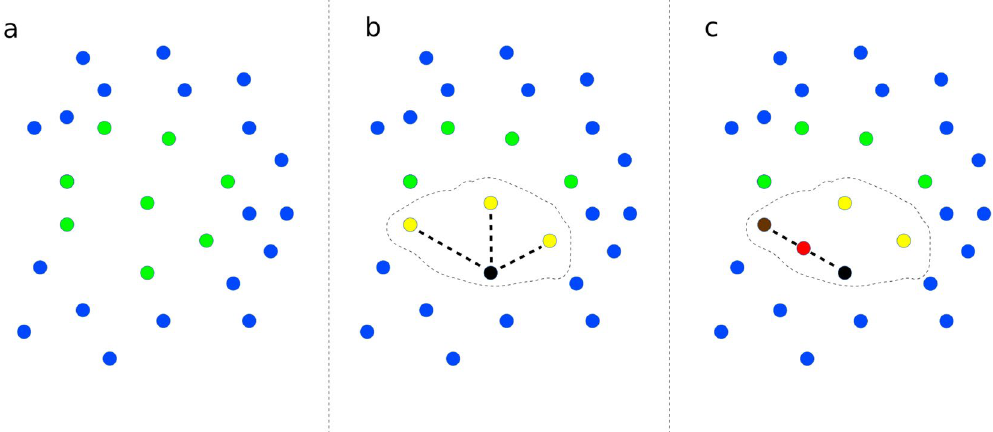
Figure 2. Graphical representation of the SMOTE algorithm. ( a ) SMOTE starts from a set of positive (green points) and negative (blue points) examples; ( b ) It then selects a positive example (black) and its k nearest neighbors among the positives (yellow points, with k = 3), ( c ) Finally one of the k nearest neighbours is randomly selected (brown point) and a new synthetic positive example is added, by randomly generating an example (red point) along the straight line that connects the black and brown points. The procedure depicted in ( b , c ) is repeated for all the positives, by adding each time a new synthetic example similar (in an Euclidean sense) to the other positive